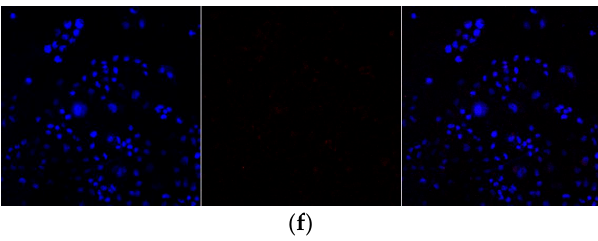
Figure 4. The effects of PACC and PADF on the accumulation of ADM in BEL-7402/5-FU cells (×400). ( a ) BEL-7402 cells, ( b ) BEL-7402/5-FU cells, and ( c ) BEL-7402/5-FU cells were treated with 50 μ g/mL PACC; ( d ) BEL-7402/5-FU cells were treated with 85 μ g/mL PACC; ( e ) BEL-7402/5-FU cells were treated with 23 μ g/mL PADF; ( f ) BEL-7402/5-FU cells were treated with 45 μ g/mL PADF.